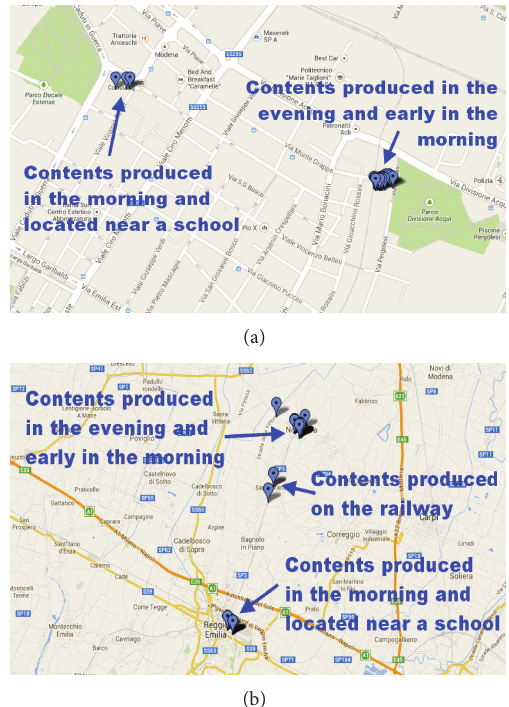
Figure 14: Examples of personal information inferred by combining location and content production time of the 25 most recent contents produced by a